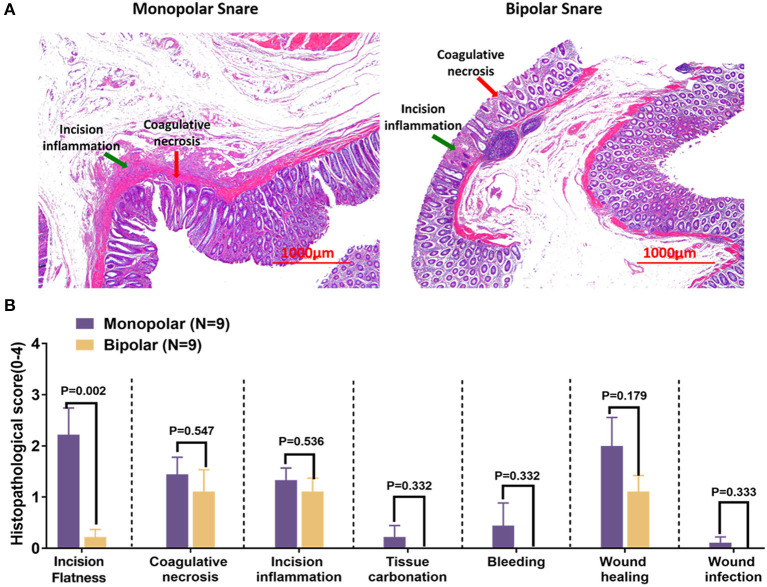
Histological changes of the digestive tract on day 13 after endoscopic resection by the monopolar snare and bipolar snare. (A) H&E staining of porcine rectal tissue removed by the two snares. Incision inflammation and coagulative necrosis were indicated by green arrow and red arrow, respectively. Scale bars: 1,000 μm. These pictures were captured by camera of microscope. (B) Histological scores of incision flatness, coagulative necrosis, incision inflammation, tissue carbonation, bleeding, wound healing, and wound infection were compared between monopolar and bipolar groups. The evaluation standards of these histological scores are summarized in Supplementary Tables 1–7. Data presented as means ± SD (N = total quantity of resection). Student t test was taken to do statistical analysis.